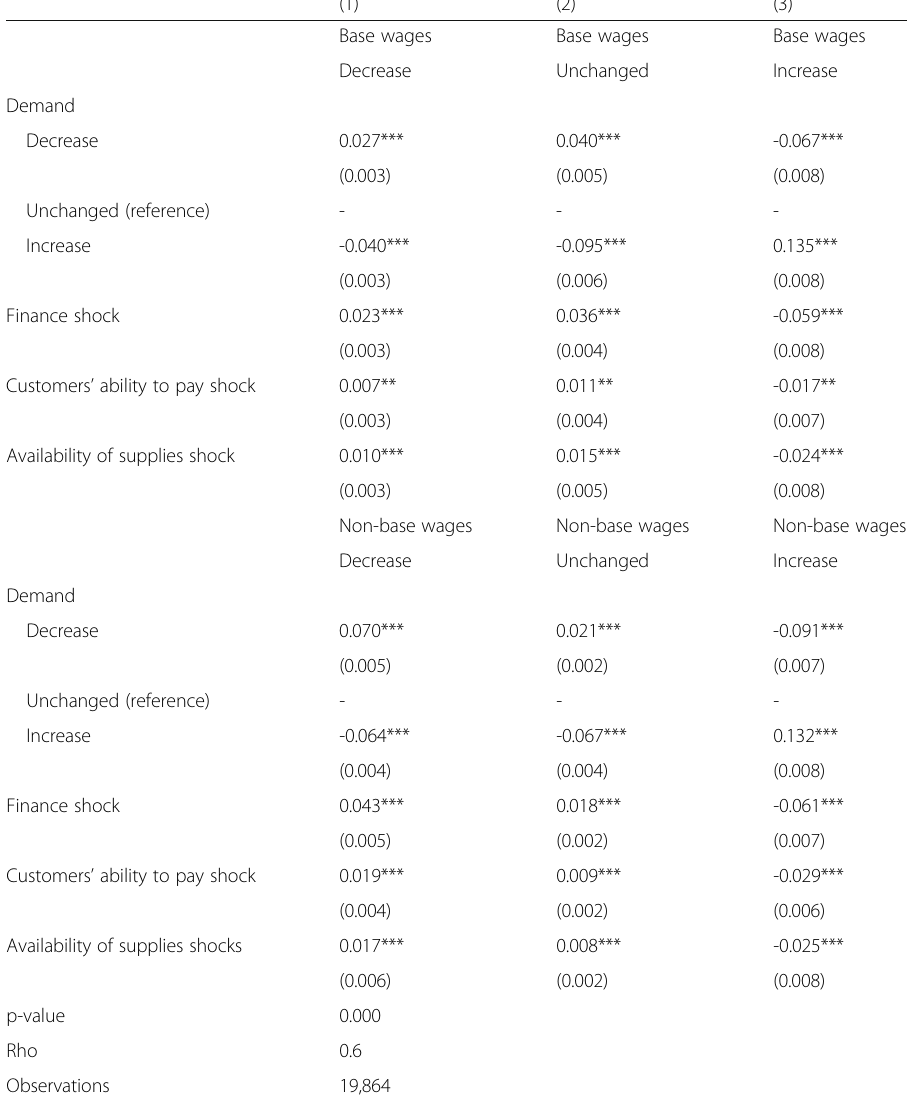
Table 7 Base wage and non-base wage adjustment, SUR